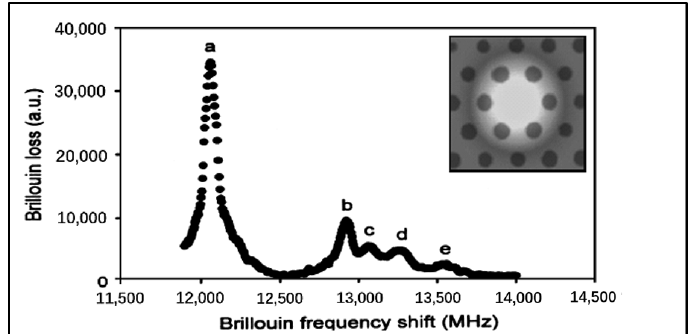
Figure 2. Multi-peak BGS due to multiple acoustic modes (indicated by the letters a, b, c, d, e). (Reprinted/Adapted) with permission from [32] © The Optical Society.